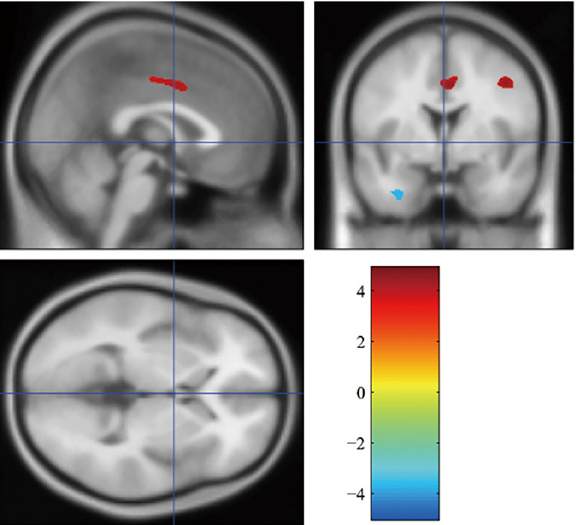
Fig 1. Statistical parametric map showing a higher or lower regional cerebral metabolic rate of glucose (FDR corrected p < 0.05) in APOE ε 4 carriers compared with APOE ε 4 noncarriers. The color bar indicates the t value. The cluster size > =